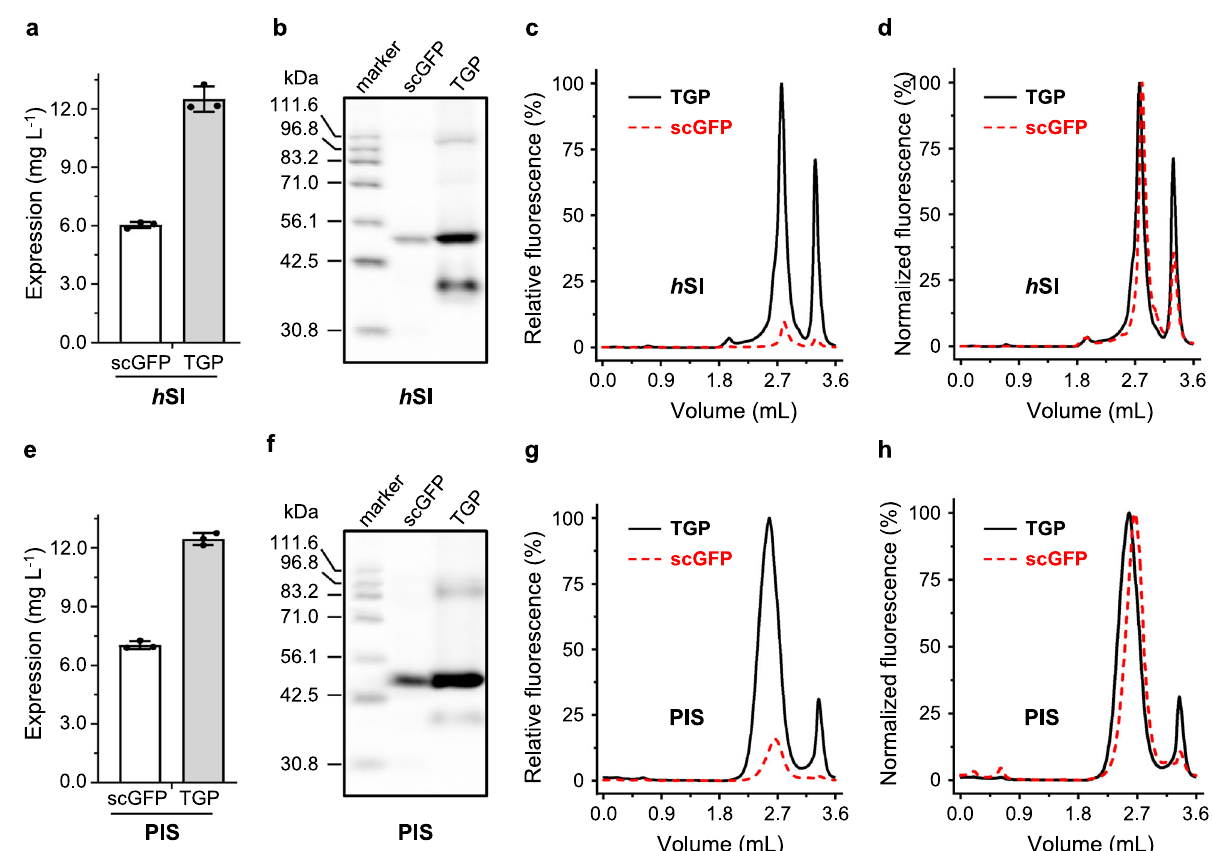
Fig. 5 Replacing GFP with TGP improved expression of two human membrane proteins in insect cells. Assessment of h SI expression was based on fl uorescence counts ( a ), in-gel fl uorescence ( b ), and relative FSEC intensity ( c ). Normalized FSEC traces of h SI-TGP and h SI-scGFP are shown in d . Assessment of PIS expression was based on fl uorescence counts ( e ), in-gel fl uorescence ( f ), and relative FSEC intensity ( g ). Normalized FSEC traces of PIS-TGP and PIS-scGFP are shown in h . Mean and standard deviation ( a , e ) or a representative ( b – d, f – h ) of three independent experiments on cells with different passage numbers are shown. In c , d , g , and h , TGP traces are shown as black solid lines and scGFP traces are shown as red dashed lines. FSEC fl uorescence-detection size exclusion chromatography, GFP green fl uorescent protein, TGP thermostable